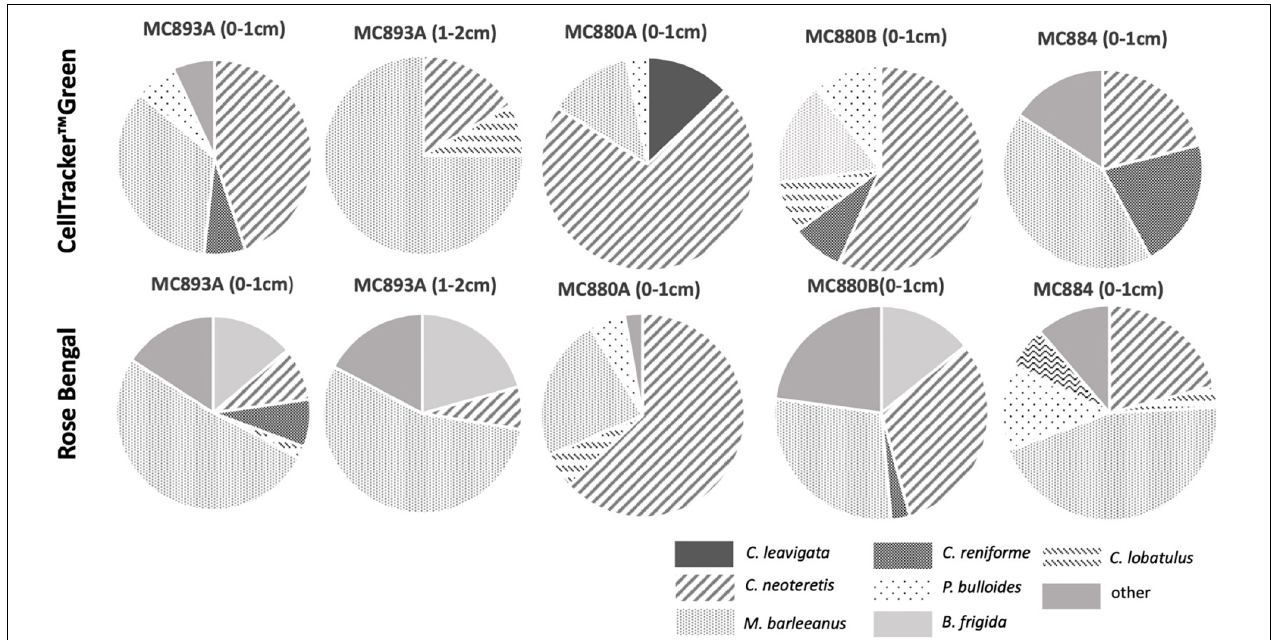
FIGURE 5 | Foraminiferal species composition at Lomvi pockmark (Vestnesa Ridge) and control site using CellTracker TM Green (live) and Rose Bengal (live + recently dead). Plots are based on direct counts ( Tables 2 , 3